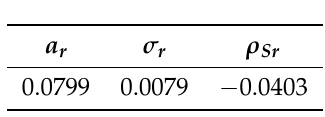
Table 2. Parameters of the Financial Market Model.